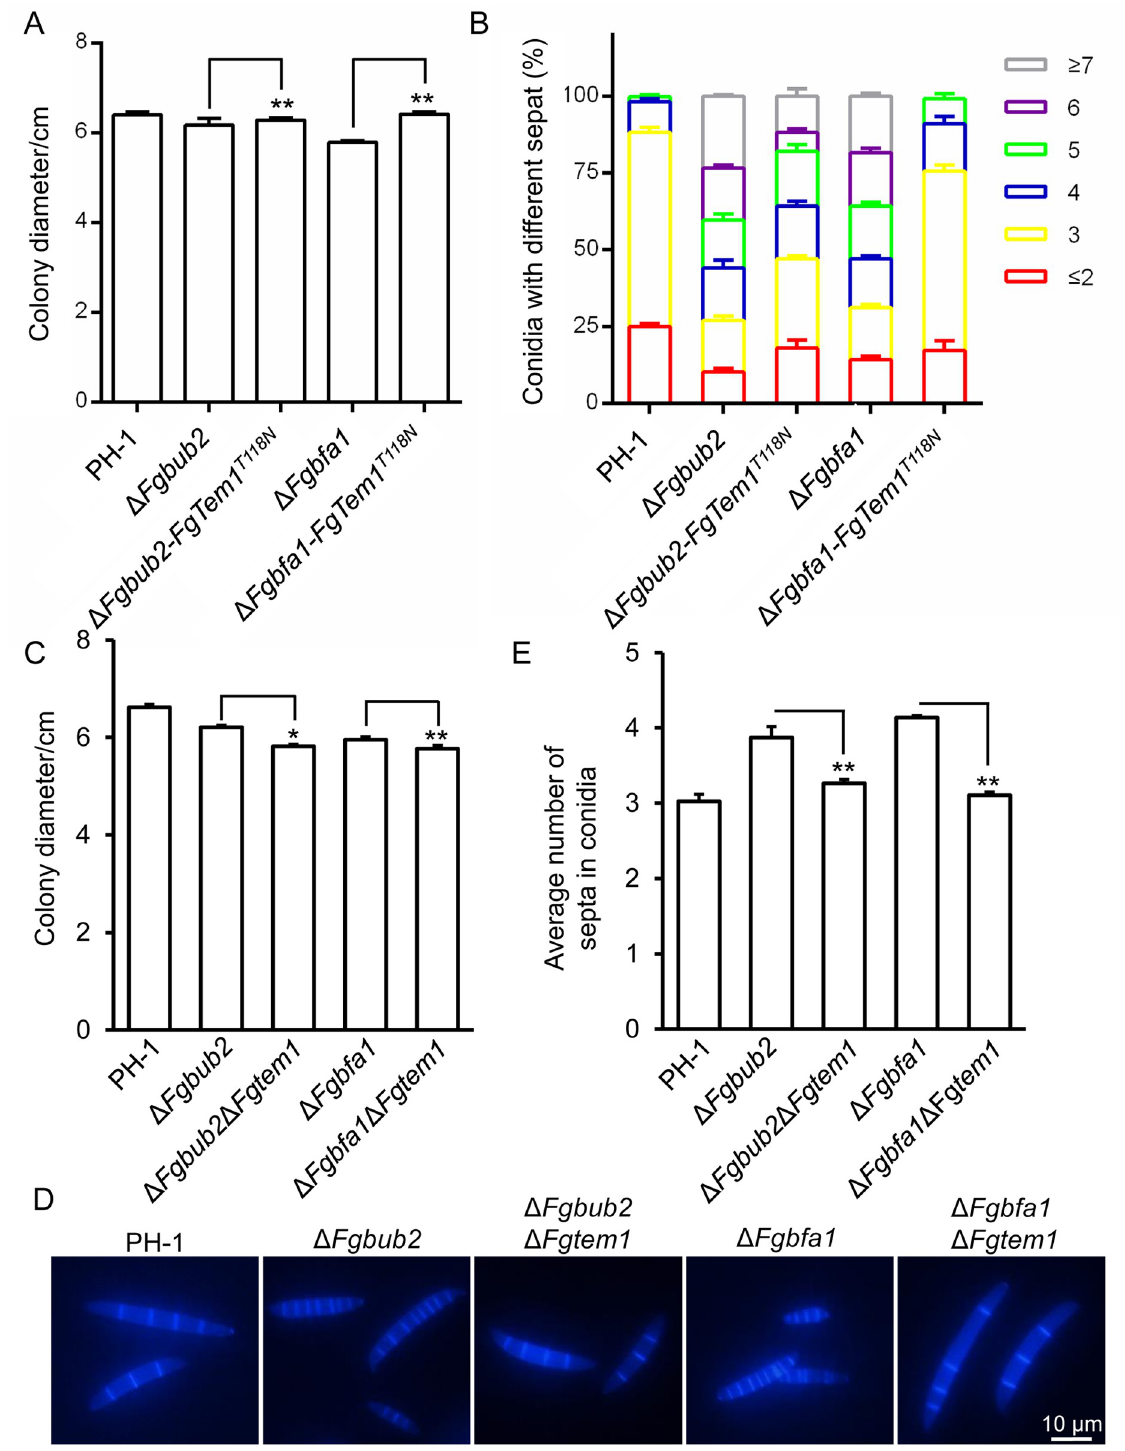
Fig 9. Genetic relationship of FgBub2 and FgBfa1 with FgTem1. (A) The dominant negative isoform of FgTem1 (FgTem1 T118N ) partially rescues the vegetative growth of Δ Fgbub2 and Δ Fgbfa1 mutants. Two-tailed Student t -test was used for paired comparison of the colony diameters of Δ Fgbub2 and Δ Fgbub2 -FgTem1 T118N , Δ Fgbfa1 and Δ Fgbfa1 -FgTem1 T118N , ( �� P < 0.01). (B) Expression of FgTem1 T118N partially rescues the number of septa in Δ Fgbub2 and Δ Fgbfa1 mutant conidia. (C) Colony diameters of the PH-1, Δ Fgbub2 , FgBUB2-FgTEM1 double deletion mutant ( Δ Fgbub2 Δ Fgtem1 ), Δ Fgbfa1 , and FgBFA1-FgTEM1 double deletion mutant ( Δ Fgbfa1 Δ Fgtem1 )